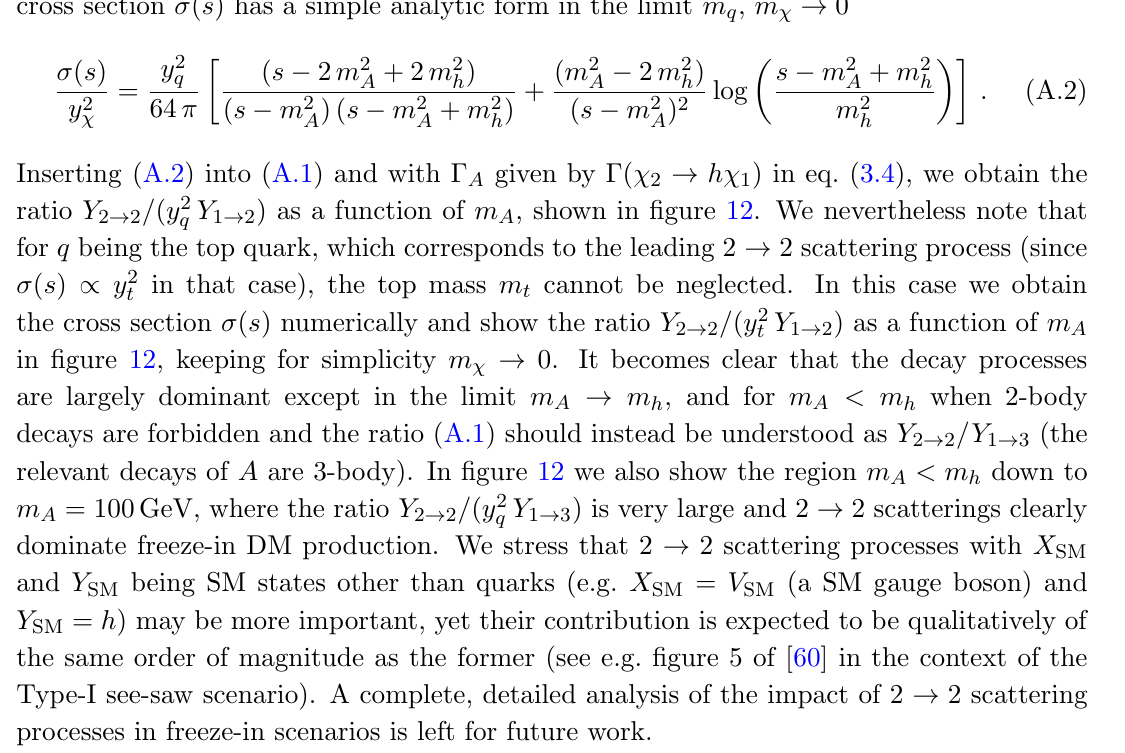
Figure 11 . Feynman diagrams for the processes A with (cid:0) the decay width of the process A A X SM + A Y SM + (cid:31) , m X and m A the mass of the initial states A and X SM and K 1 ! the (cid:12)rst modi(cid:12)ed Bessel function of the 2 nd kind. In the last step of (A.1) we have performed explicitly the integration in x = m are